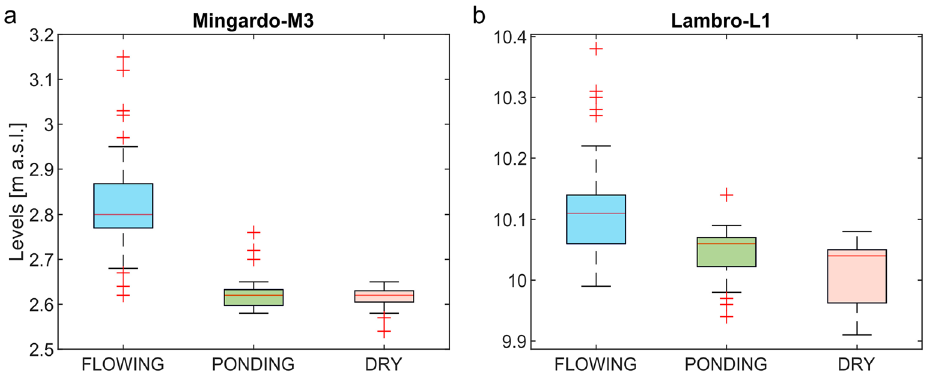
Figure 7. Distribution of water levels for considered flowing status: Flowing, Ponding and Dry. ( a ) M3 reach, ( b ) L1